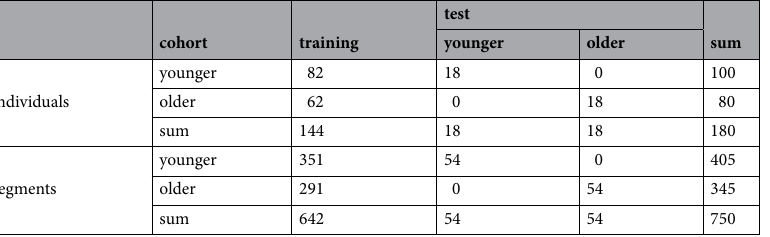
Table 1. Training- and test-splits of individuals and EEG segments, respectively. We divided all individuals in the MODA dataset into a training and test set such that, for the test set, individuals and segments were divided equally between age groups. Among a set of random splits satisfying this equality, we selected the split with median performance for algorithm